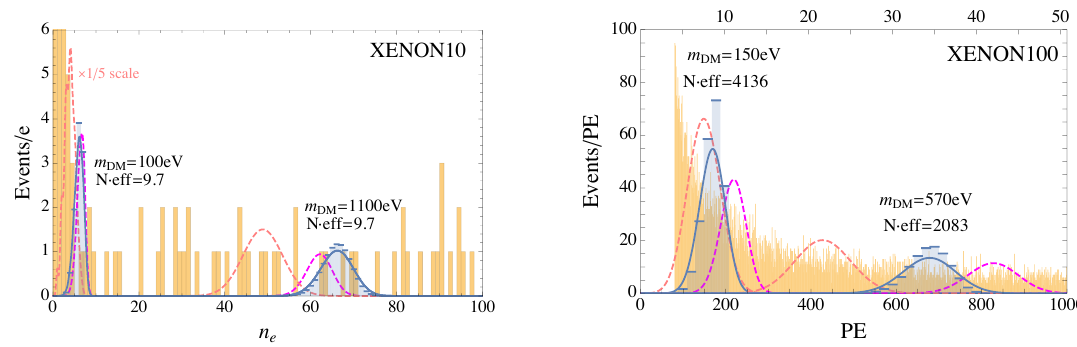
Figure 1 . Ionization (S2-only) data from XENON10 [37] ( left ) and XENON100 [39] ( right ). Top plot shows the data as the number of observed electrons, while bottom plot shows the data as the number of photoelectrons (PE) on the bottom axis and the corresponding number of electrons (1e (cid:0) =19.7PE) on the top axis. Blue gaussian lines on each plot show two examples of the expected observed signal shape for two di(cid:11)erent DM (ALP or A 0 ) masses. The blue histogram shows the signal distribution in terms of the number of electrons produced in the detector. Varying the secondary ionization model produces di(cid:11)erent signal shapes and thus di(cid:11)erent limits. We show the signal shape in pink and magenta that produces, respectively, the worst and best limit for the same two DM masses when varying the secondary ionization model. Numbers next to the blue curves give the 90% C.L. upper bound times e(cid:14)ciency on the number of signal events for those masses. produces the worst and best limit, respectively, for the same two DM masses when varying the secondary ionization